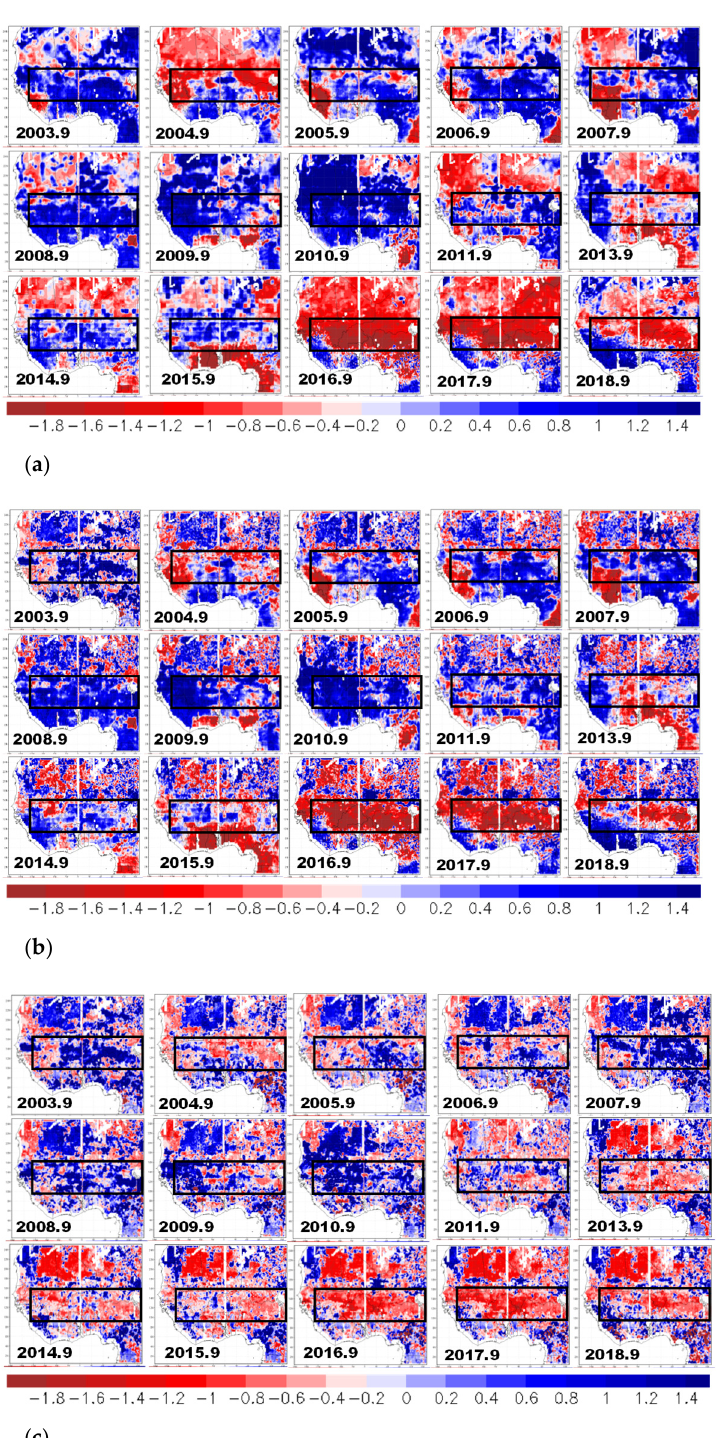
Figure 4. Spatial distribution of 𝑁𝐼 (cid:3036) for ( a ) near-surface soil moisture content (m 3 /m 3 ), ( b ) root-zone soil moisture content (m 3 /m 3 ), and ( c ) vegetation water content (m 3 /m 3 ) from the CLVDAS (September monthly averages in the period 2003–2018; spatial resolution is 0.25° × 0.25°). Black rectangle outlines the Sahel-inland region. Although variation in vegetation water content itself is slightly unclear (Figure 3c), its normalized index ( 𝑁𝐼 (cid:3036) ) based on the z-score theory clearly shows the decrease since 2011( c ). Furthermore, this trend is also shown in the near-surface and root-zone soil moisture content ( a ) and ( b ), respectively.